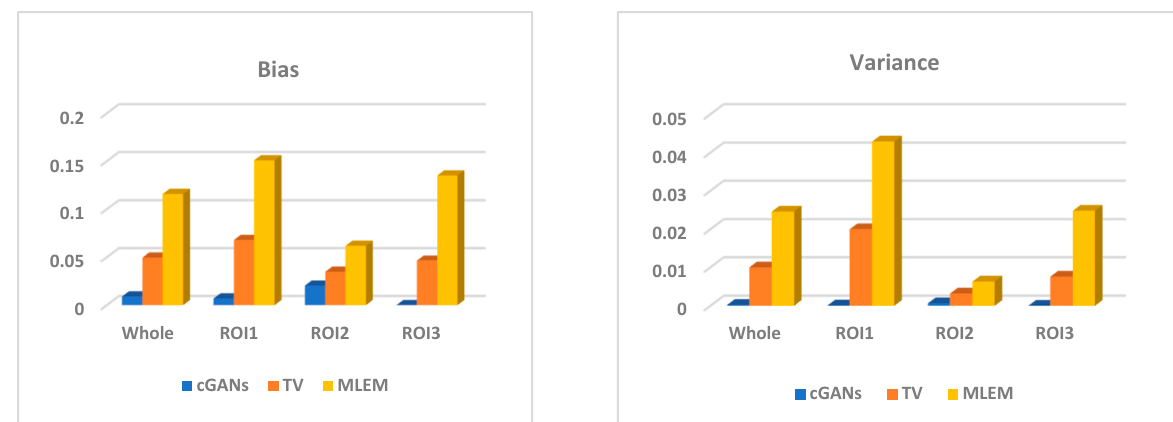
Figure 9. Bias and variance of whole images for ROI1, ROI2, and ROI3 of the Zubal thorax phantom.